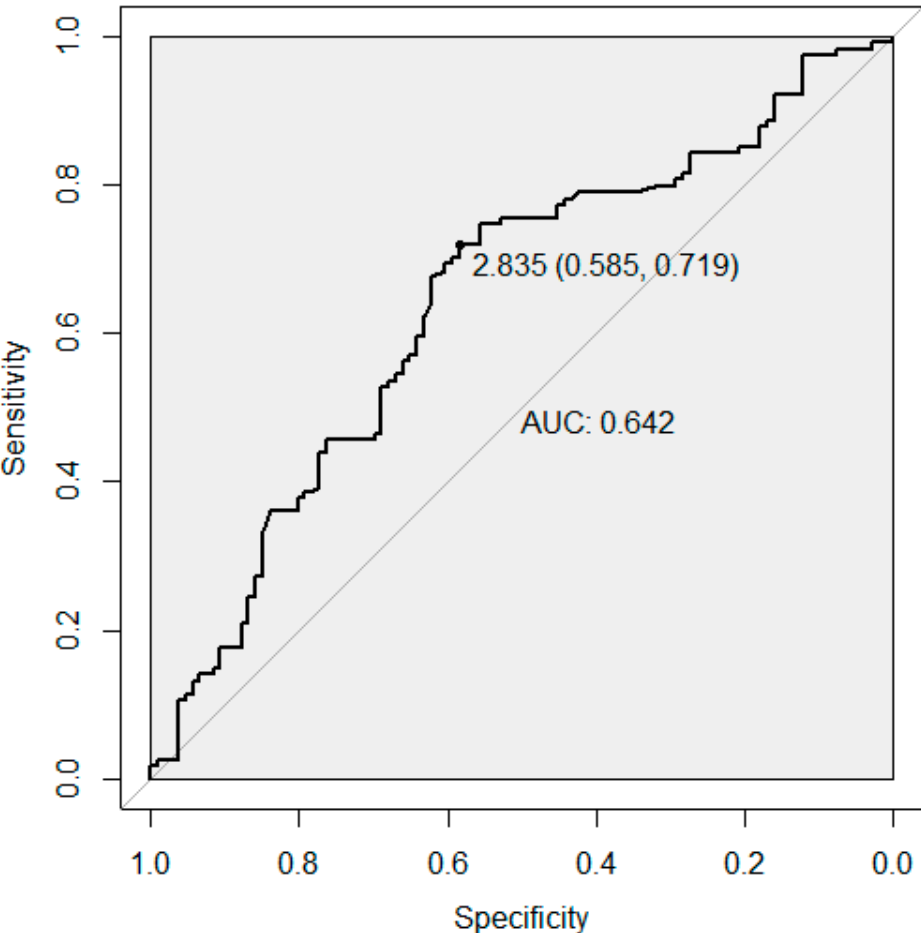
Figure 1. Receiver operator characteristic (ROC) curve for the predictive ability of the genetic risk score (GRS) for recurrent pregnancy loss. The best predictive point is shown with the ideal cut-off for the GRS and with estimates for specificity and sensitivity at that point. Abbreviation: AUC, area under the curve.